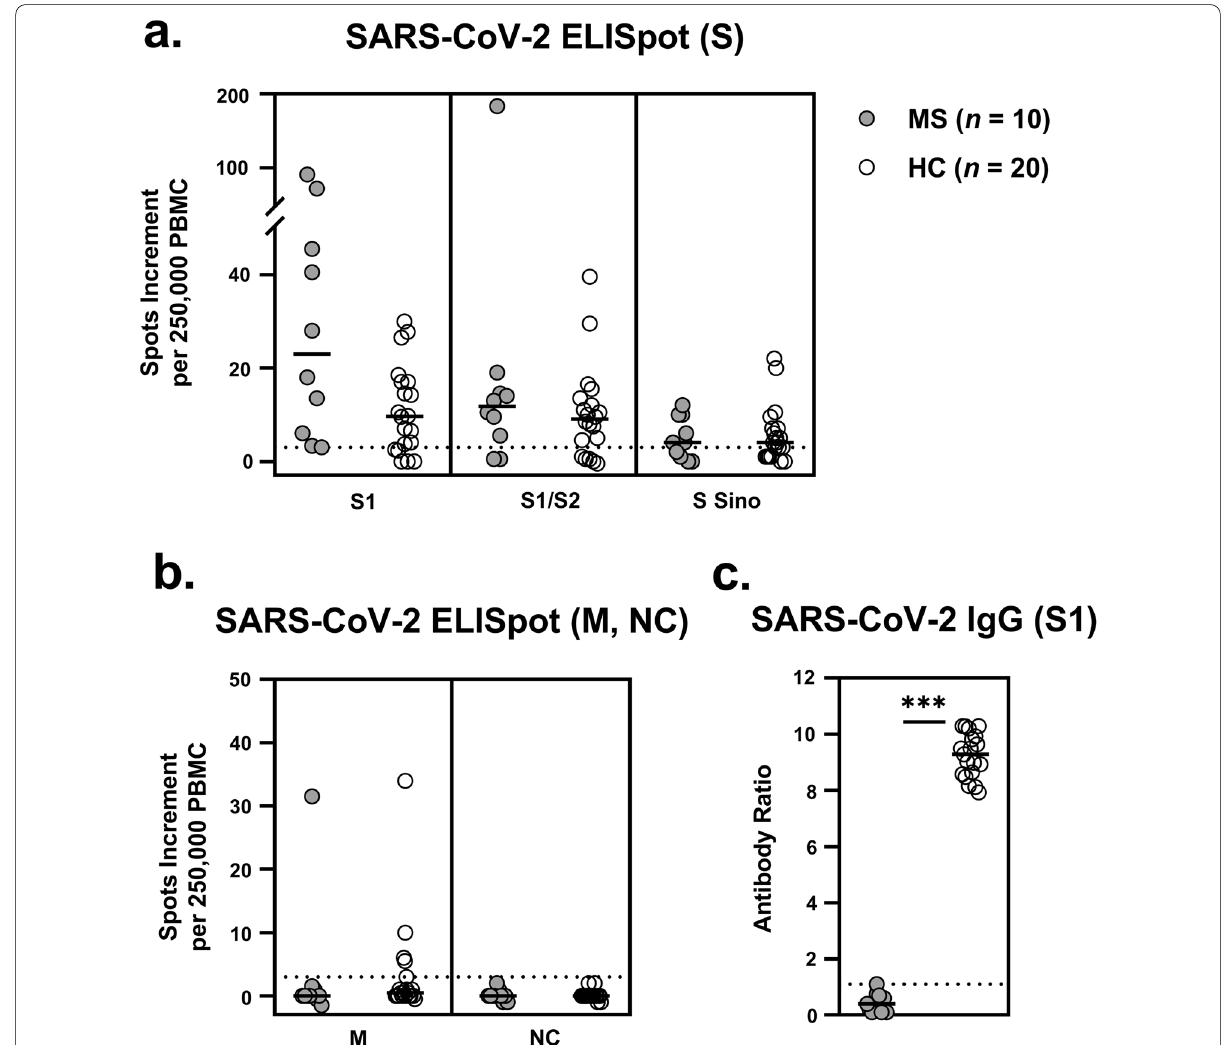
Fig. 1 SARS-CoV-2 specific ELISpot and IgG responses in patients with multiple sclerosis (MS) and matched healthy controls (HC). a ELISpot responses to spike (S), b to membrane (M) and nucleocapsid (NC) and c IgG antibody responses against S1. Horizontal bold lines indicate median values, dashed lines the cutoff for positive responses (3 spots increment or antibody ratio of 1.1). S1: peptide mix of the SARS-CoV-2 spike (S) 1; S1/ S2: peptide mix of the spike (S) 1 and S2; S Sino: S1 protein; M: peptide mix of the membrane; NC: peptide mix of the nucleocapsid. *** p <